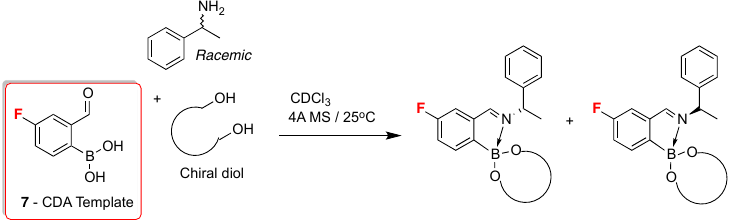
Scheme 6. Three-component coupling reaction for enatiopurity determination of chiral diols by 19